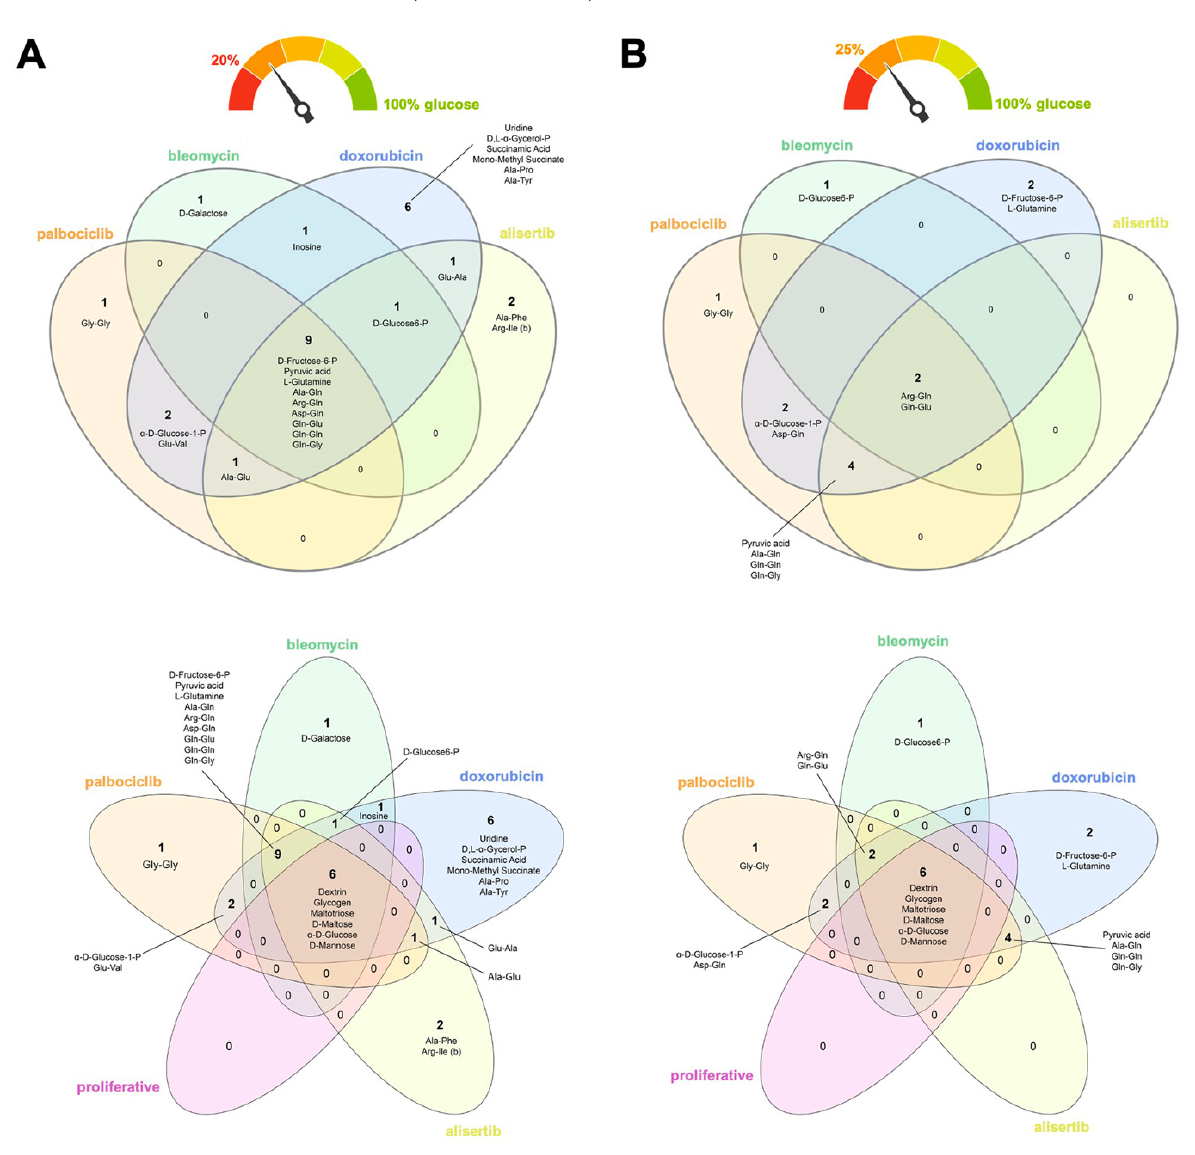
treated ones (data not shown).